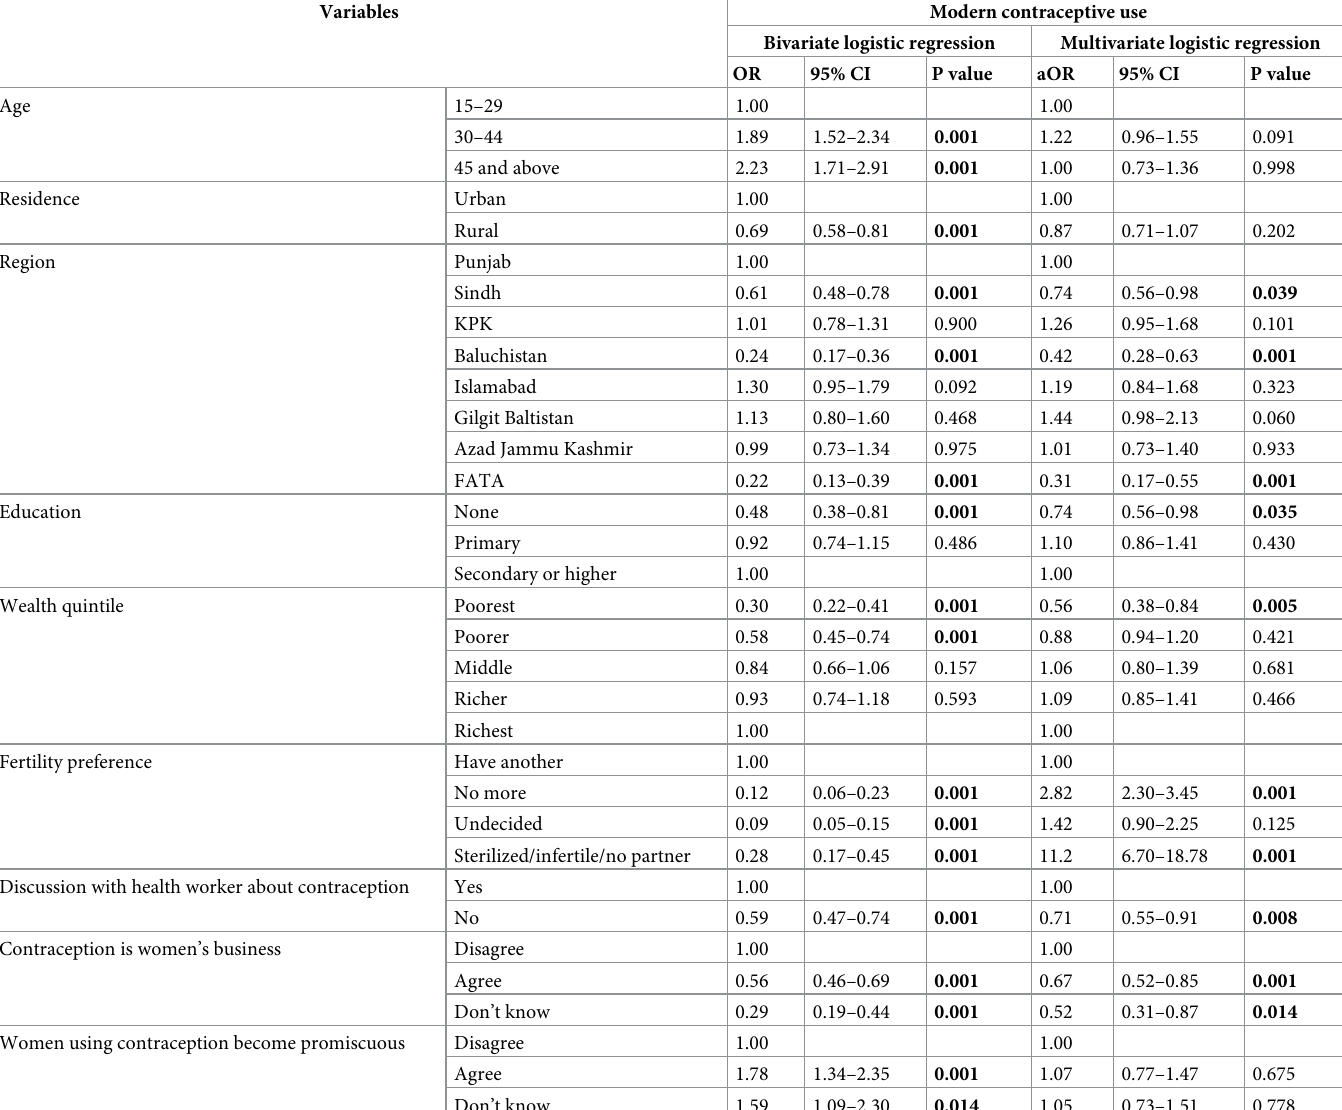
Table 3. Predictors of Modern contraceptive use among